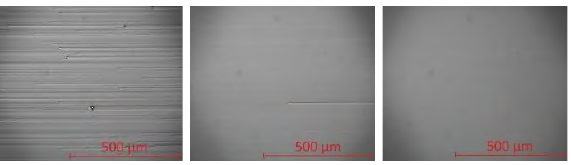
Fig . 12 . Microscopic view in depths 4 µm, 8 µm and 12 µm respectively of the V-shape polished surface grinded with the D15 tool.